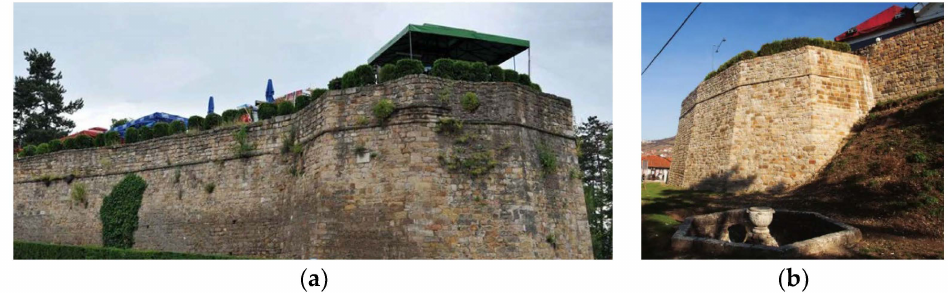
Figure 5. Northern Tabia. ( a ) North-south view (Photo source: private archive of Vladan Vidosavlje-